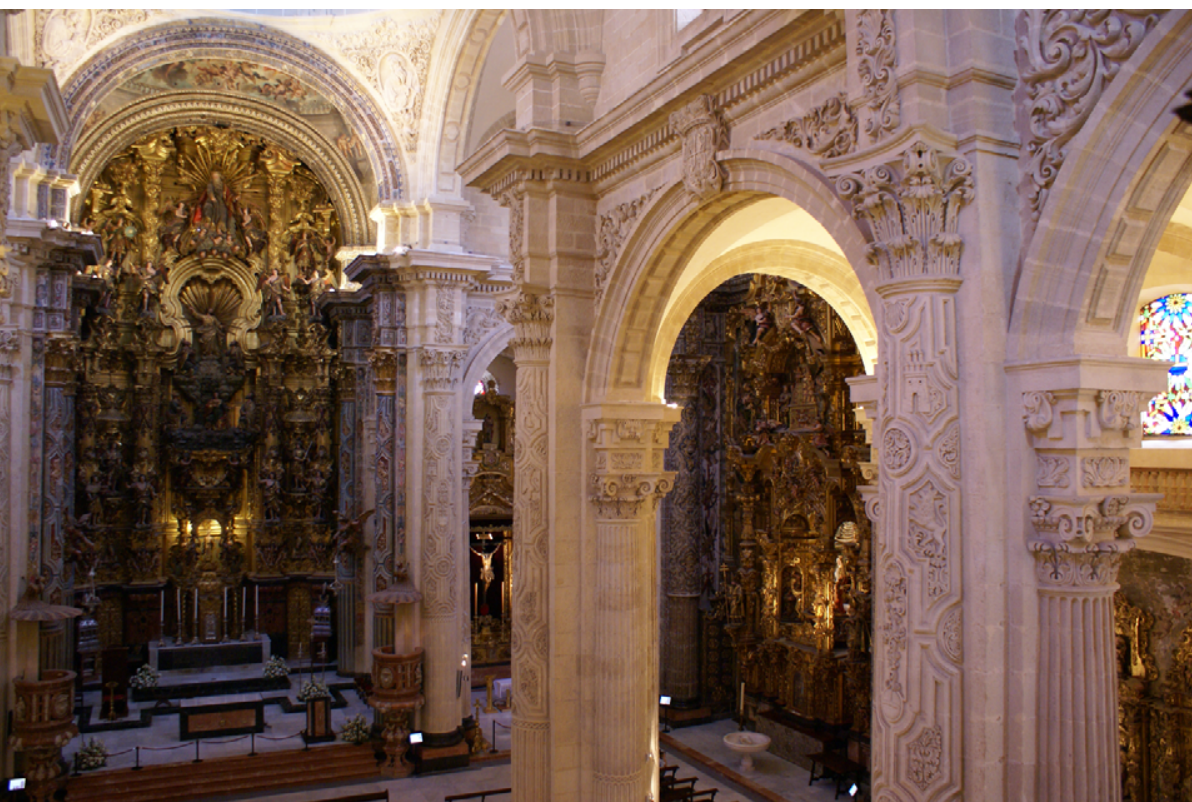
Figure 16: Interior of the ex–collegiate church of El Salvador, Seville. Photo by